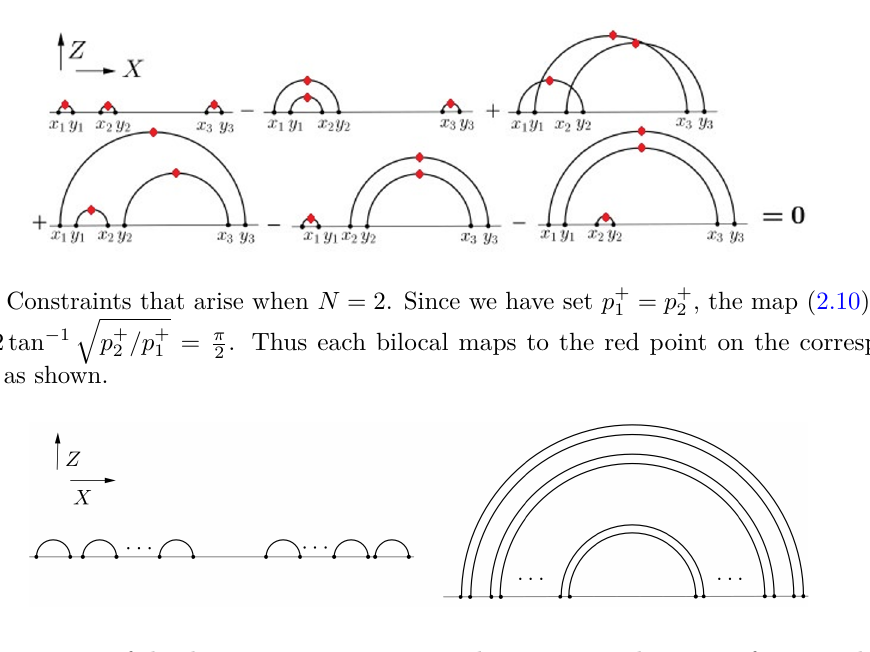
Figure 7 . Two of the diagrams participating in the constraint that arises for general N